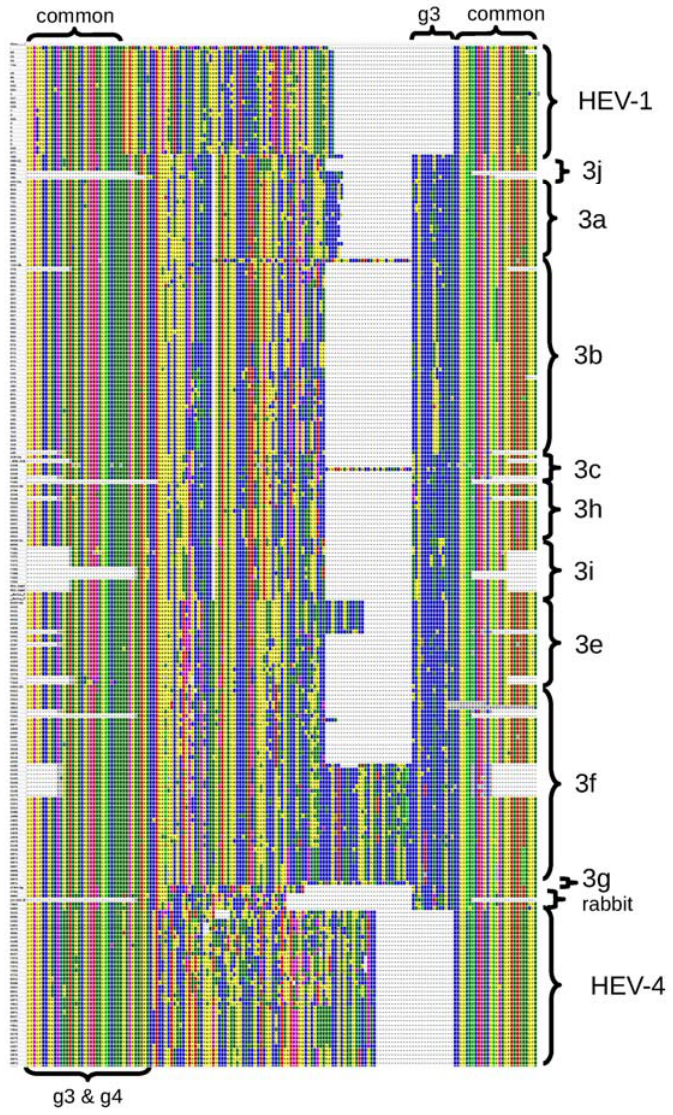
Figure 5. Scheme of the alignment of the deduced amino acid sequences including the HVR, which is flanked by conserved regions (some sequences only partially span this region and gaps in the conserved flanks are not part of the alignment). Obtained from the Alignment Explorer of MEGA6